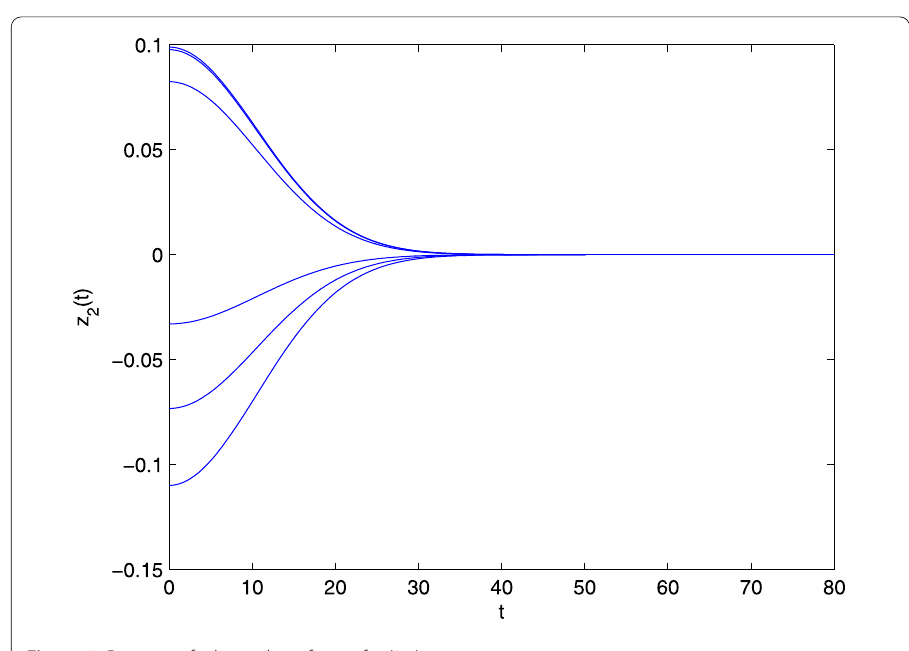
Figure 2 Diagram of relationship of t – z 2 for